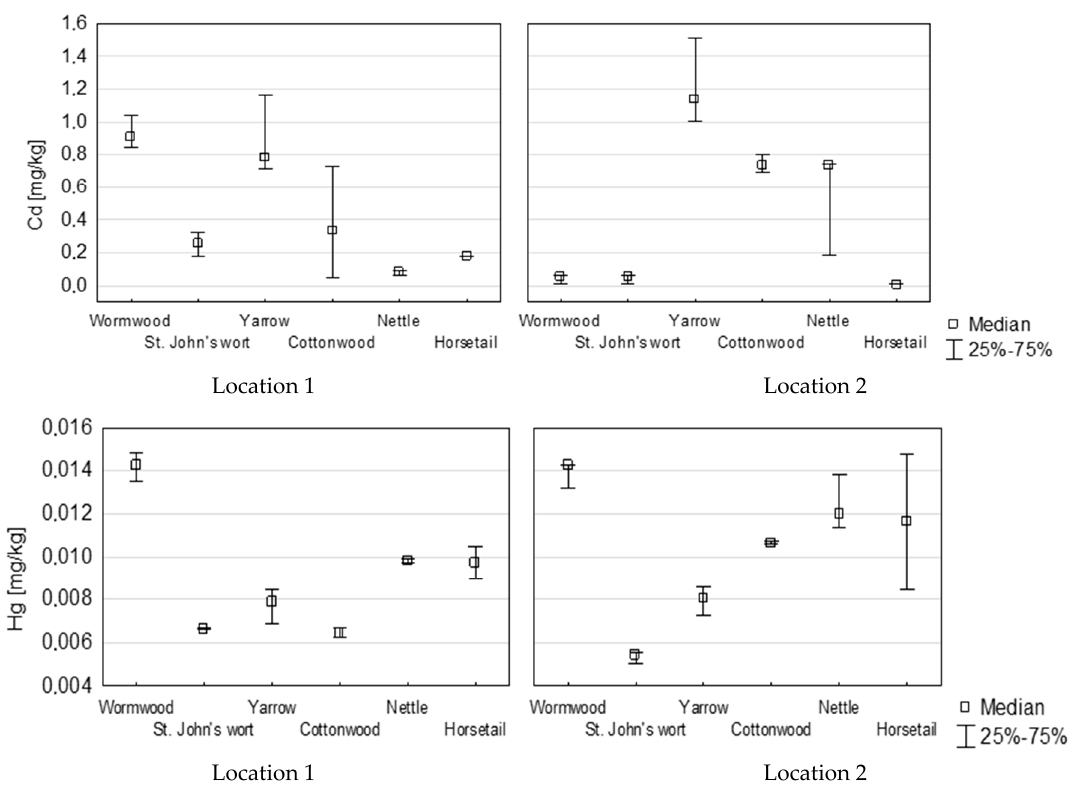
Figure 3. Concentration of Pb, Cd and Hg in self-collected species of herbs (mg/kg).